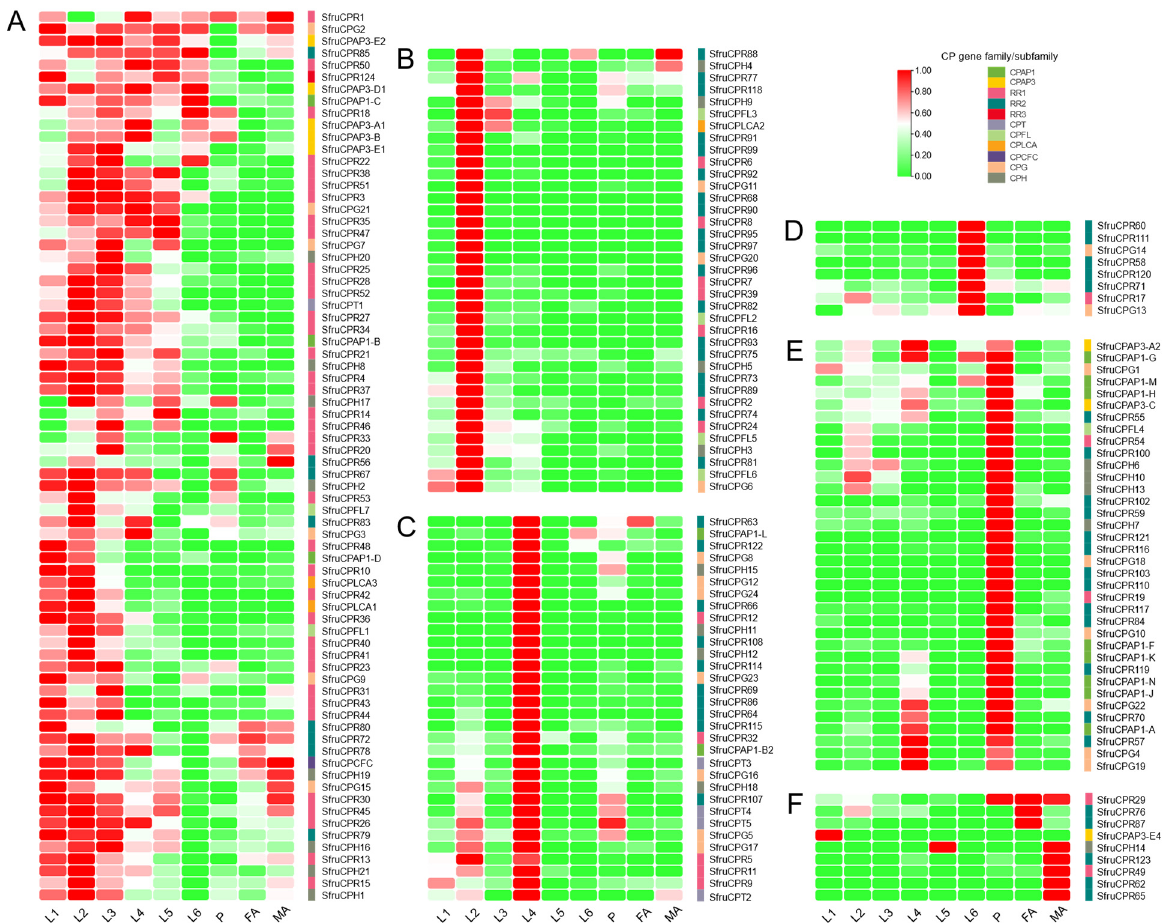
Figure 2. The expression profiles of CP genes across developmental stages. ( A – F ) highlight the hierarchically clustered CP genes with stage-specific expression patterns. The heat map was illustrated using the TPM values of CP transcripts calculated with the RNA-Seq data. Red and green indicate the high and low expressions, respectively. L1–L6: 1st–6th instar larvae; P, pupae; FA, female adult; MA, male adult.